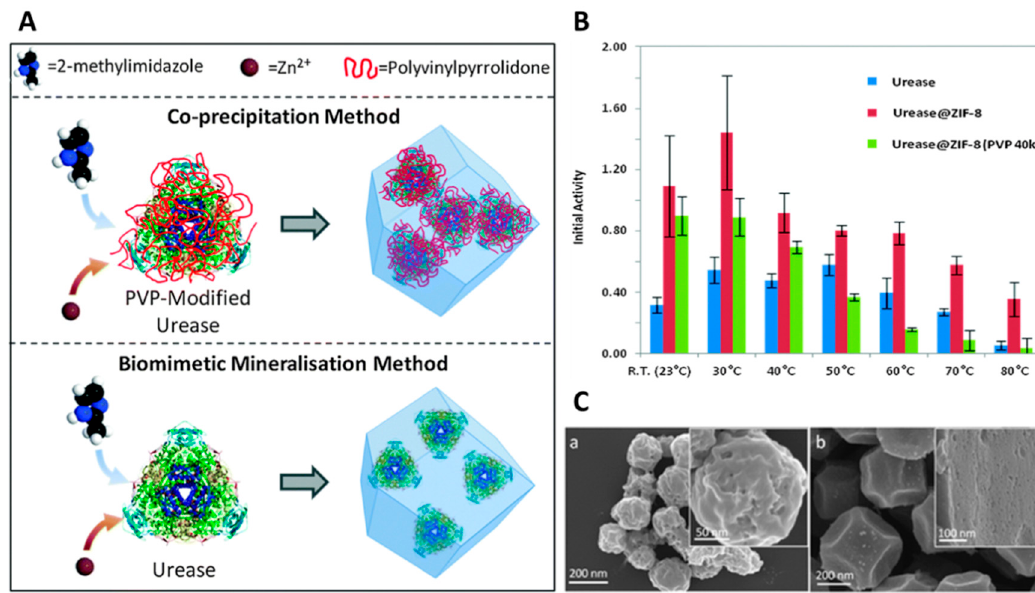
Figure 5. ( A ) Urease@ZIF-8 prepared with (top) and without (down) PVP as an additive. ( B ) Initial activity at different reaction temperatures. ( C ) SEM image of urease@ZIF-8 prepared with (C- a ) and without (C- b ) PVP as an additive. Adapted with permission from [107]. Copyright 2016 Royal Society of Chemistry.